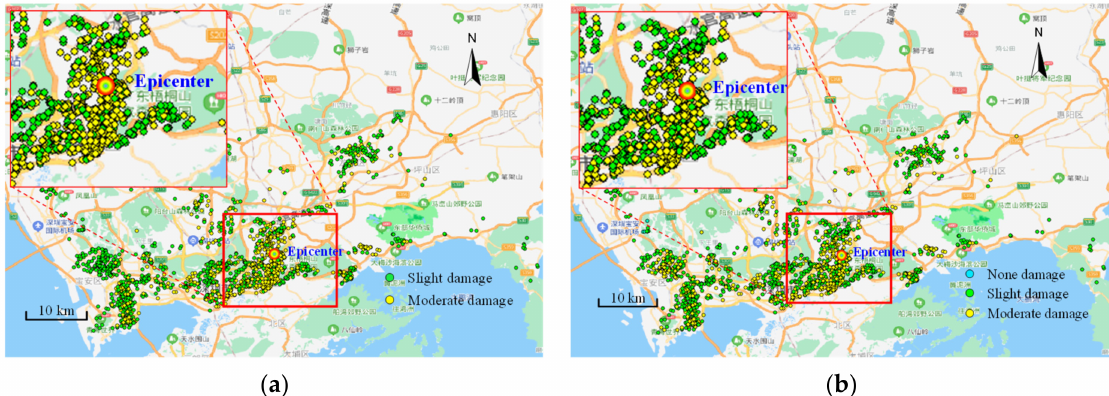
Figure 18. Distribution of damage states of the M6.5 earthquake scenario: ( a ) time history analysis results; ( b ) MI- CNN results.